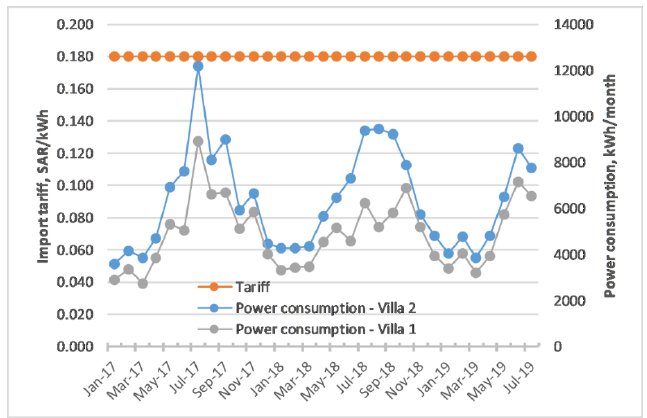
Figure 27. Load curve for the monthly consumption for Villa 1.